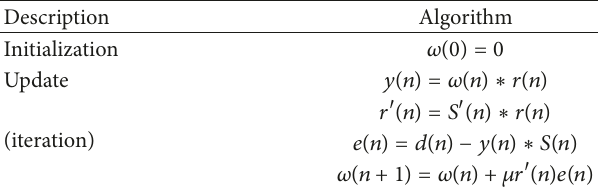
Table 3: Numerical process of FxLMS